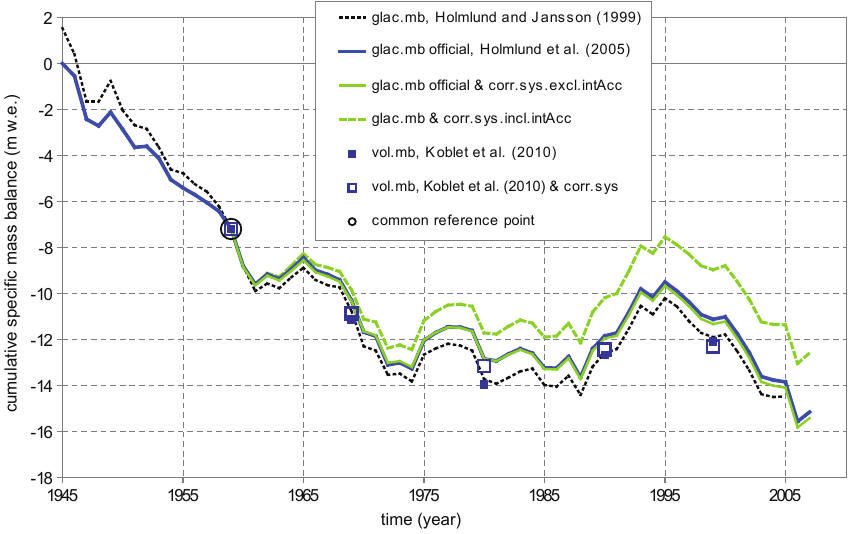
Fig. 3. Cumulative glaciological and volumetric mass balance series of Storglaci¨aren. The official glaciological mass balance series (Holm- lund et al. (2005), Tarfala Research Station data) is compared to the new volumetric mass balance data by Koblet et al. (2010; 1959-69- 80-90-99). In addition, two glaciological mass balance series are shown which are based on the official one but corrected for directional uncertainties including/excluding internal accumulation (for details see text) as well as the old official series by Holmlund and Jansson (1999). In order to have a common reference point, all changes are relative to the value of 1959 of the “official” glaciological data series (Holmlund et al. (2005), Tarfala Research Station data; −